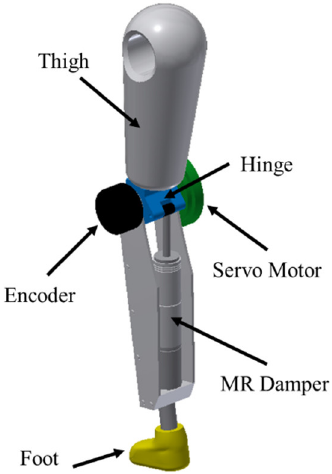
Figure 9. The configuration of above knee prosthesis using MR damper [85].